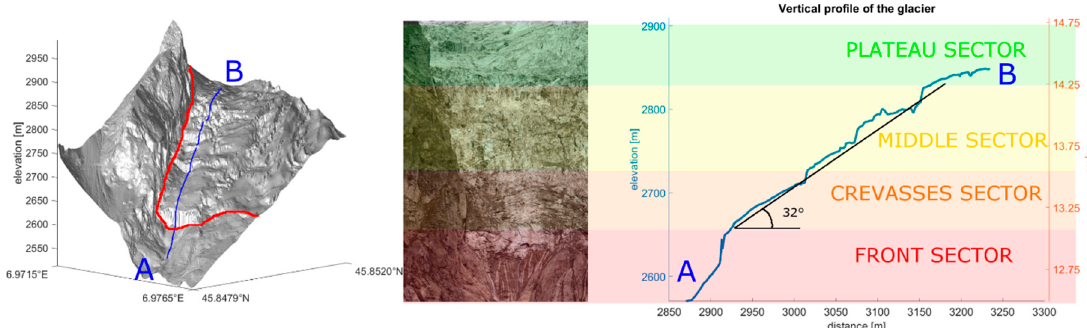
Figure 8. On the left, the DTM produced by the LiDAR survey in June 2014. Blue line identifies the location of the selected vertical profile. The red line highlights the glacier margins. On the right, representation of the vertical profile of the glacier. On average, the glacier lies on a flat plane with a mean slope of 32°. Different colours highlight the sectors of the glacier characterized by different physical features. The right vertical axis reports the pixel dimension increasing upward within the image.